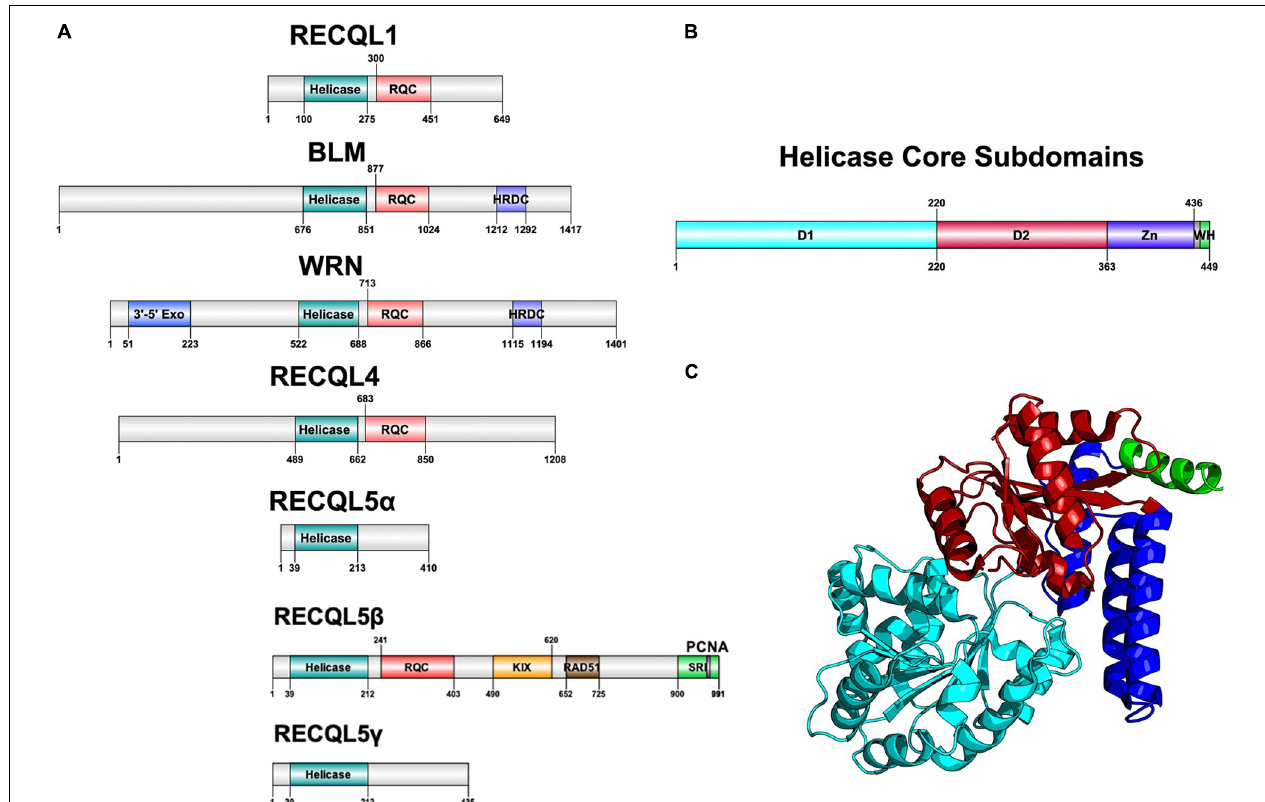
FIGURE 1 | Structure of RecQ helicases. (A) Domain architecture of all five RecQ helicases, aligned by core helicase and RQC domains. (B) Subdomains of the core helicase domain of RECQL5. Zn refers to the Zn-binding domain and WH refers to the winged helix-like structure of RECQL5. (C) Cartoon structure diagram of the core helicase domain, colored by subdomain. Gene structure diagrams were designed using Domain Graph (DOG), and the protein structure was designed using PyMol with the crystal structure used in Newman et al. (2017). Data on gene structure was also retrieved from Croteau et al.